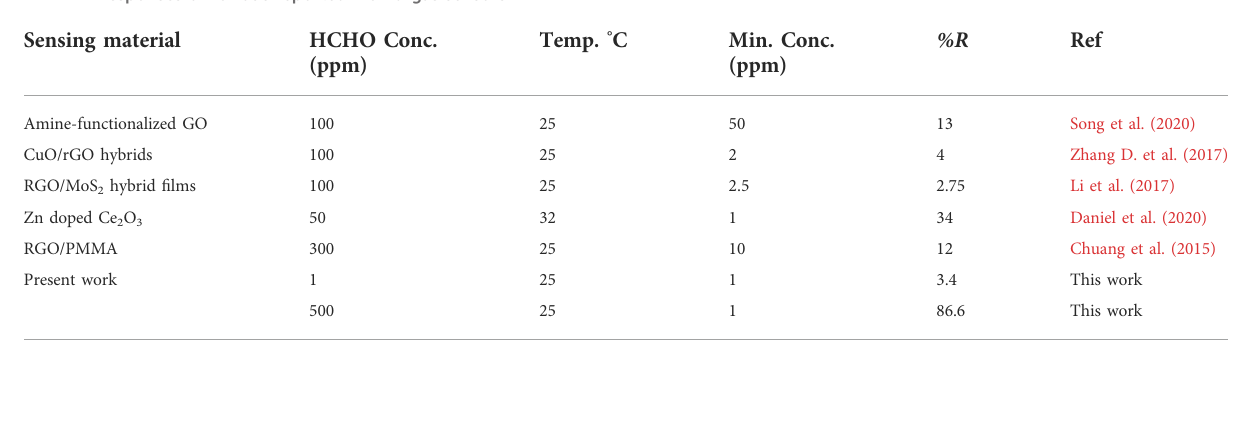
TABLE 1 Responses of various reported HCHO gas